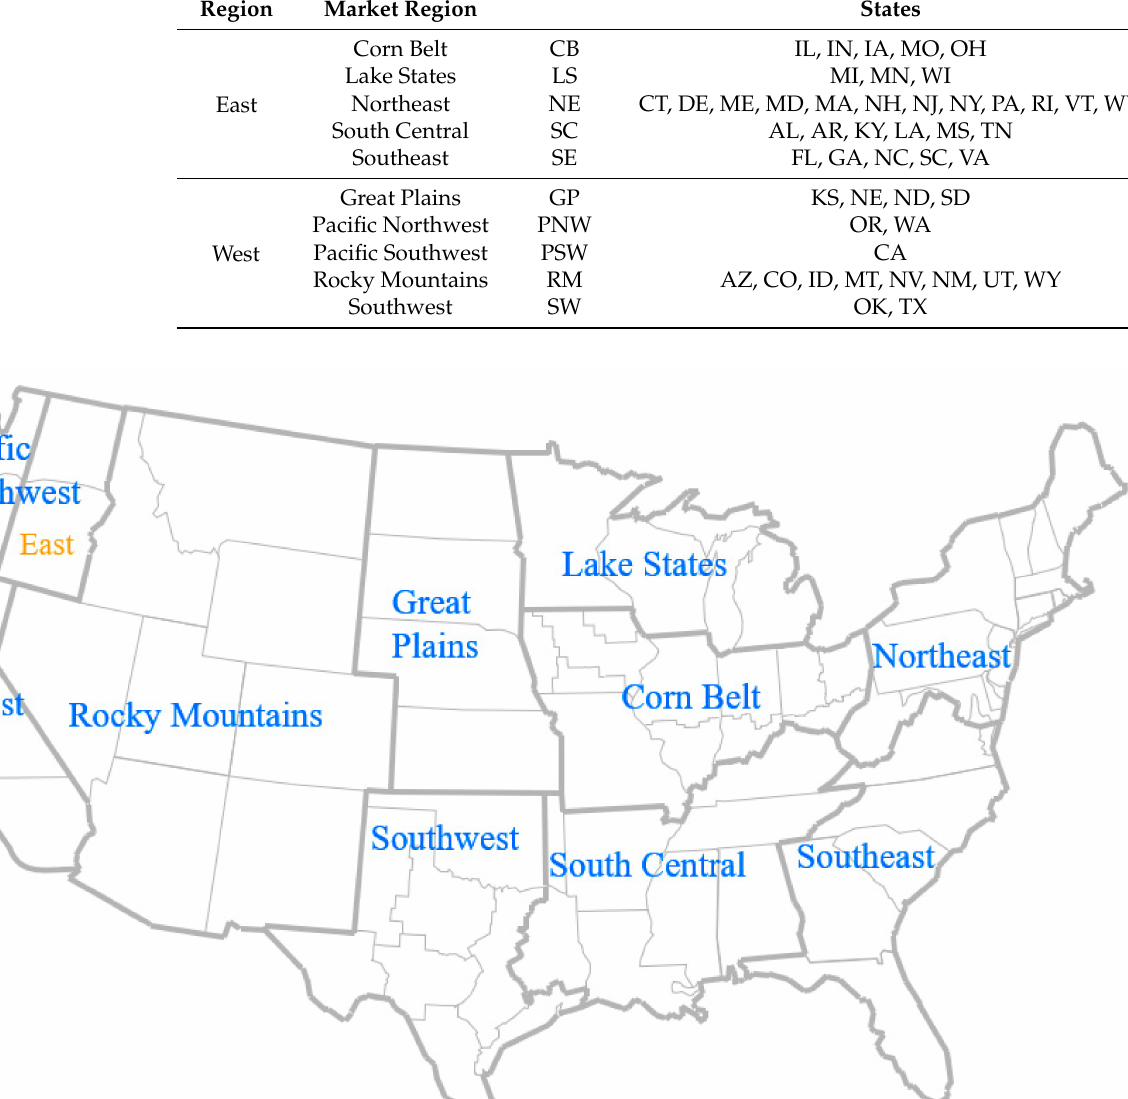
Table 2. Definition of US market regions used in fixed effects.